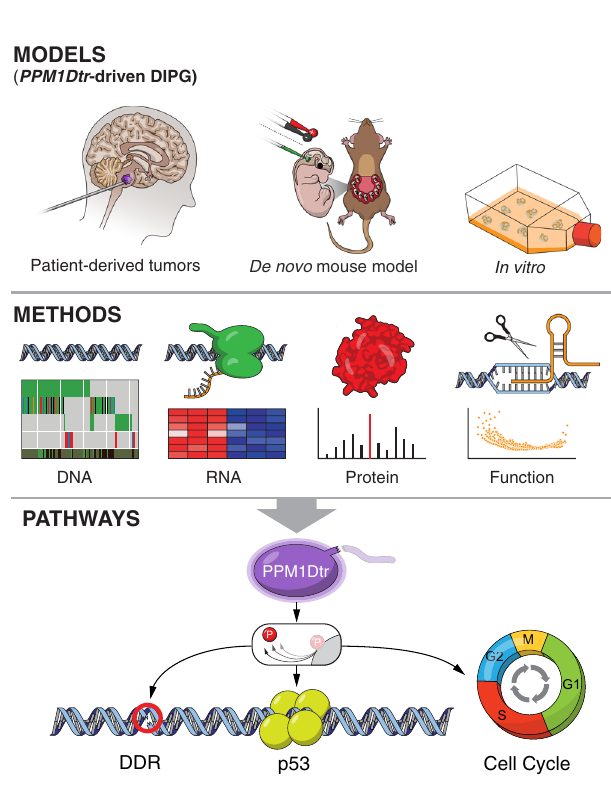
Fig. 7 Integrative analysis of PPM1D -mutant DMG models. Schematic depicting the overall method and fi ndings of the study. Top panel: an array of models used in the study including biopsy of DMG tumors, de novo mouse models of PPM1D driven DMG using in utero electroporation, and in vitro models including patient-derived cell lines. Middle panel: integrative approach employing whole-genome sequencing of patient tumors, gene expression analysis, proteomics, and phosphoproteomics screens, and CRISPR screens used to study the function and mechanism of PPM1D mutation in DMG. Bottom panel: convergence of the oncogenic function of PPM1Dtr on p53, cell cycle and DDR pathways using the integrative approach in the middle